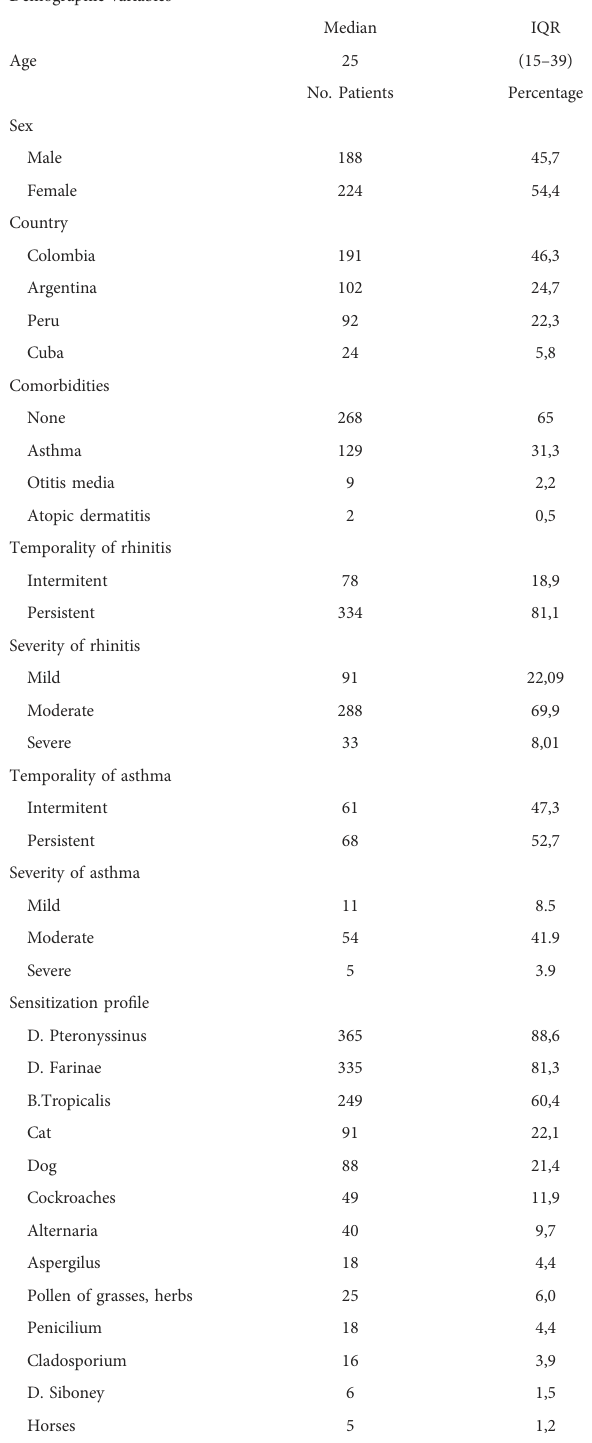
TABLE 1 Demographic data, clinical characteristics and sensitization pro fi